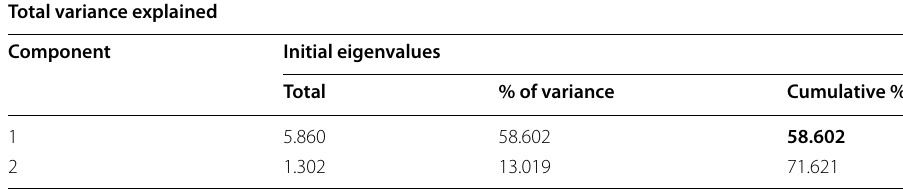
Table 3 The highest components of PCA for the third runs Total variance explained Component Initial eigenvalues Total % of variance Cumulative